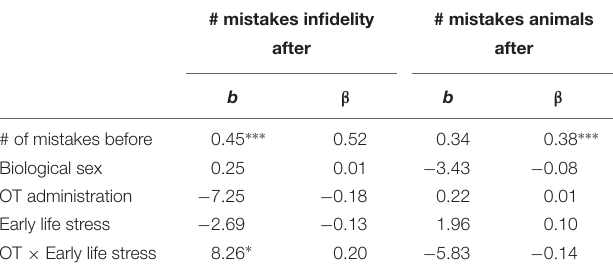
TABLE 5 | Regression coefficient for predicting the change in accuracy in detecting infidelity and poisnious animals by OT administration and early life stress (Study 2).